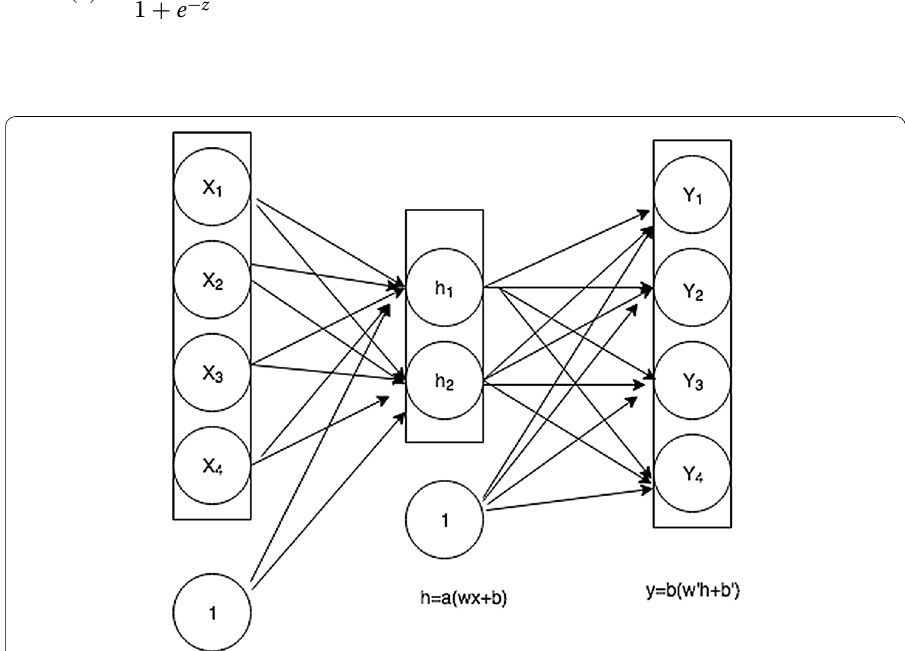
Fig. 1 A three-layer neural